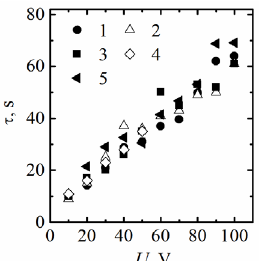
Fig. 4. Dependence τ=f(U) in the oxidation of the Ti6Al4V alloy. j a =1 A dm –2 ; с А , g dm –3 : 5(1); 10(2); 25(3); 50(4); ∙ ∙